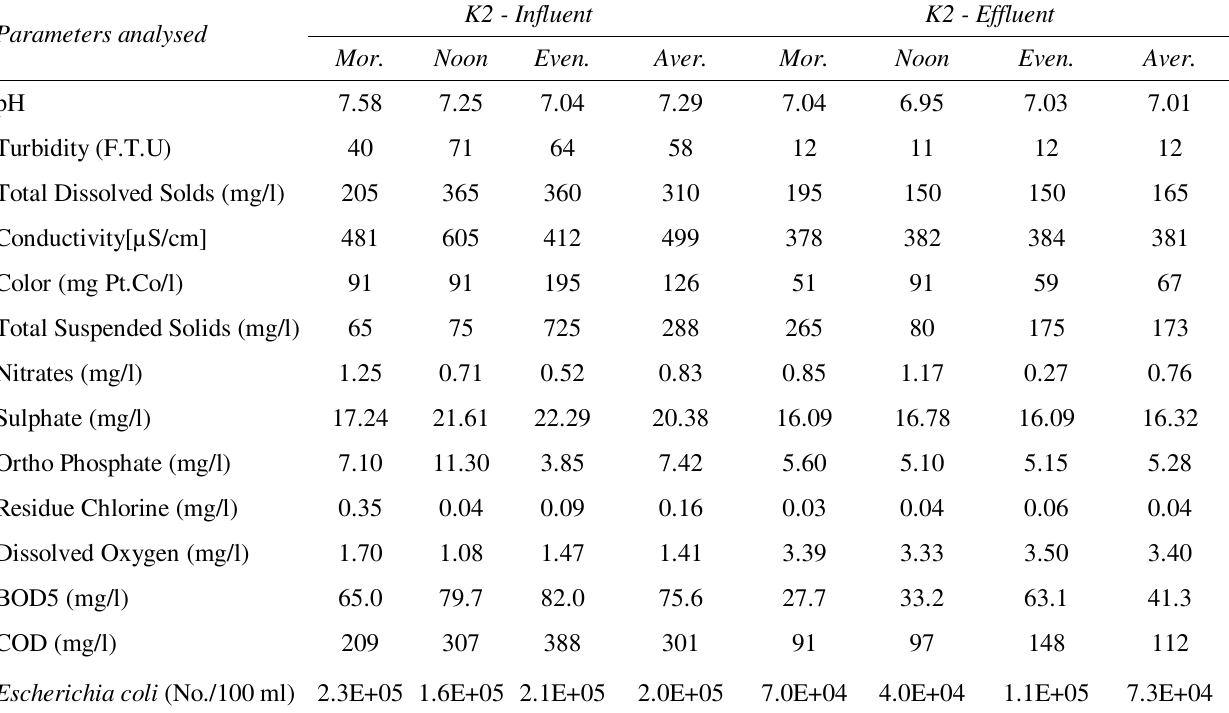
NOTE: Mor = Morning; Even = Evening; Aver = Average.